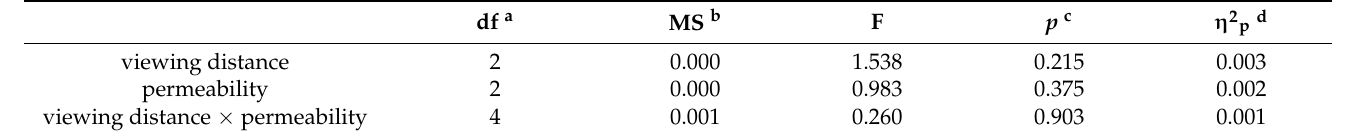
Table 4. Impacts of different viewing distances and permeability levels on (cid:52) E ST.